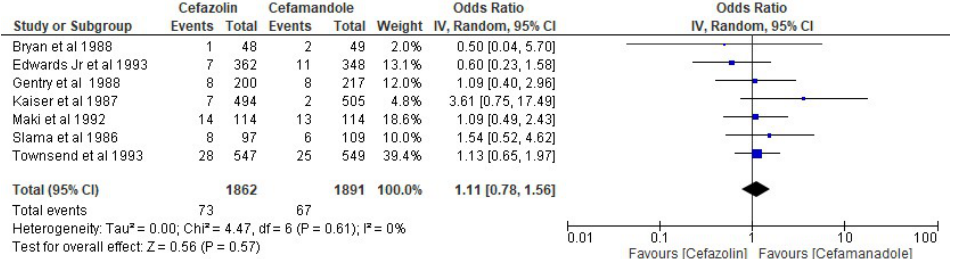
Figure 5. The rate of SSIs in the cefazolin group vs. cefamandole group. The included studies were